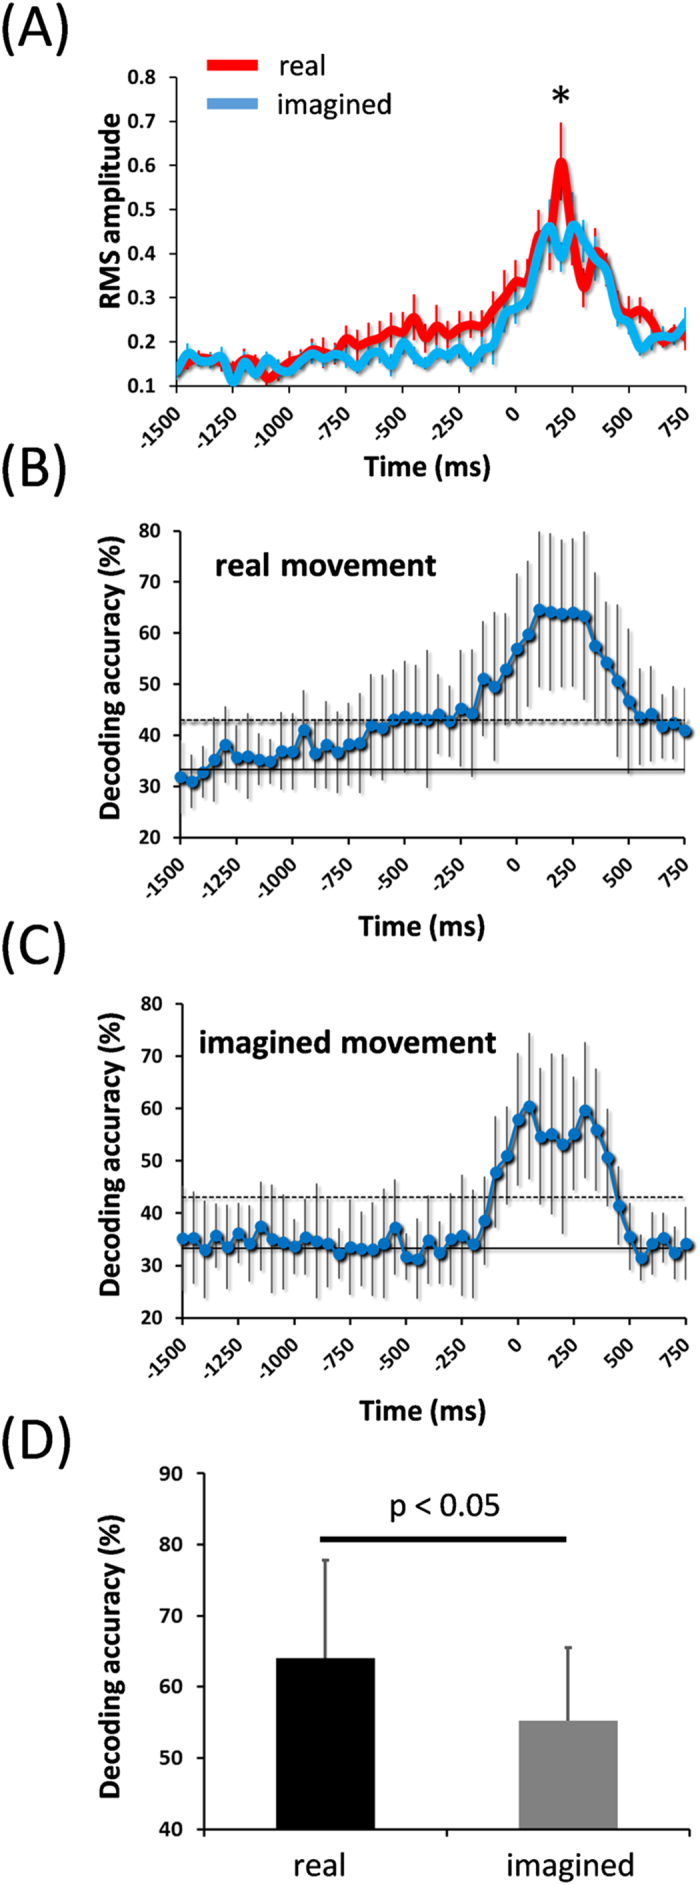
Intensity of cM1 activity and decoding accuracy during real and imagined movements.(A) cM1 activity sharply peaked at 200 ms in the real movement, whereas only small peaks were observed at 150 and 250 ms in the imagined movement. A significant difference in the intensity of cM1 activity between real and imagined movements was observed at 200 ms (Mann–Whitney U-test, *p < 0.01) (error bar, standard error). (B) In the real movement, decoding accuracy gradually increased before response onset and peaked at 100 ms (error bar, SD). Decoding accuracy was plotted for the first sample acquired in the time window. The two horizontal solid and dotted lines indicate decoding accuracy at the chance level (33.3%; binomial test, p = 0.01 for both). (C) In the imagined movement, decoding accuracy showed two peaks at 50 and 300 ms (binomial test, p < 0.01). (D) Significant differences in decoding accuracy between real and imagined movements were observed at 200 ms (Mann–Whitney U-test, p < 0.05).